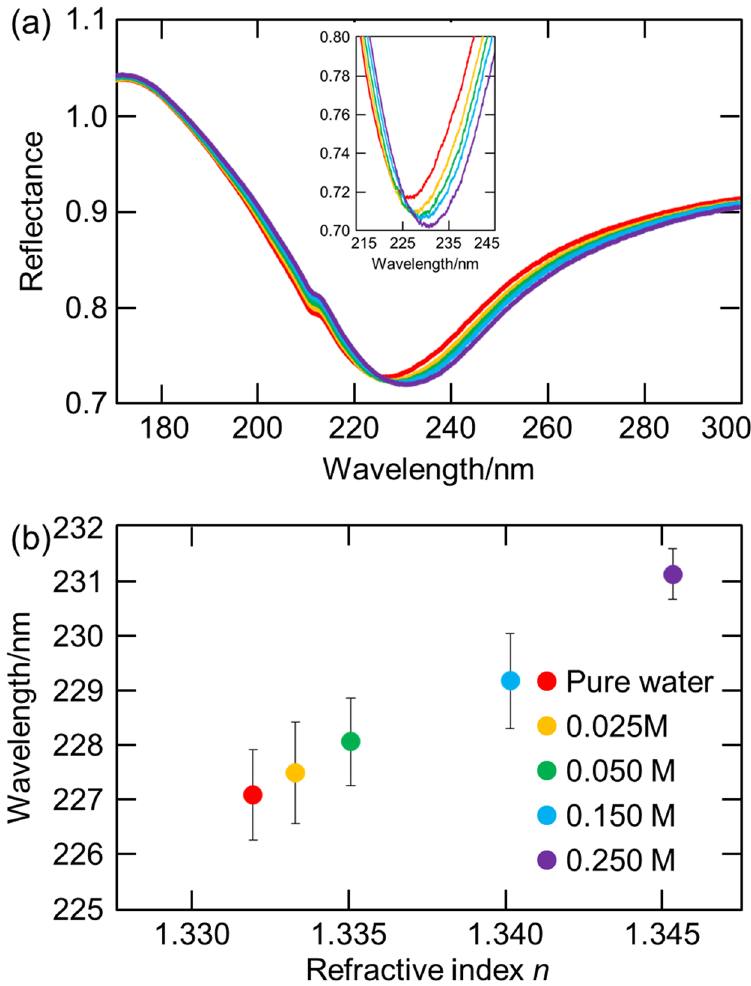
Figure 3. ( a ) Reflection spectra and ( b ) SPR wavelength dependence on the refractive index of the Al thin film on the sapphire prism in pure water and sucrose water solutions with various concentrations (0.025–0.250 M). The refractive index was measured in the visible